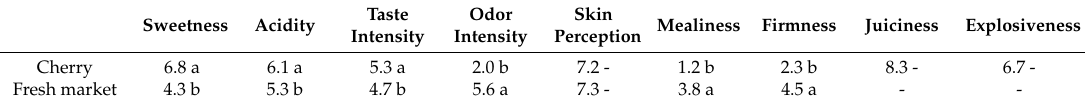
Table 4. Differences between cherry and fresh market tomatoes for sensory traits. Within columns, different letters indicate significant differences (Student-Newman-Keuls test, at p <